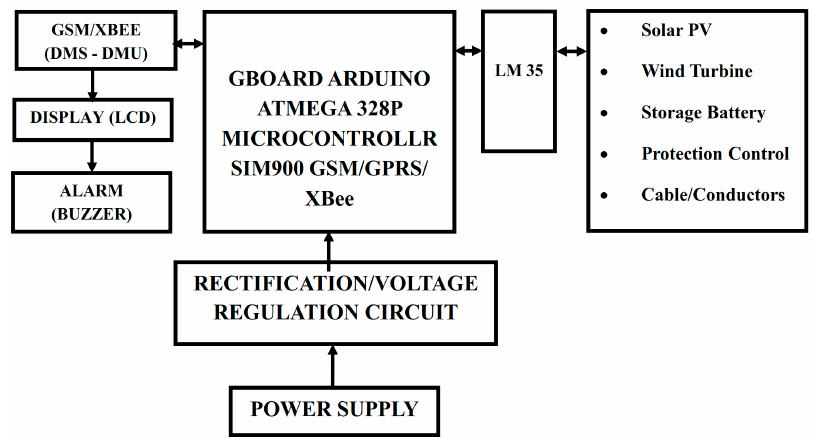
Figure 2. Block diagram of distributed energy resources (DERs) thermal condition monitor.